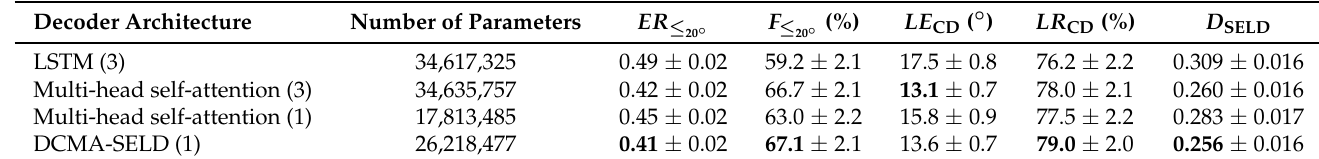
Table 5. Performance for different decoder architectures in our DCMA-SELD on the TNSSE 2021 development dataset. The numbers in the parentheses indicate the numbers of decoder blocks used in the models to perform three predictions. All data represent mean values and associated 95% confidence intervals. The highest performance in each metric is indicated in bold.